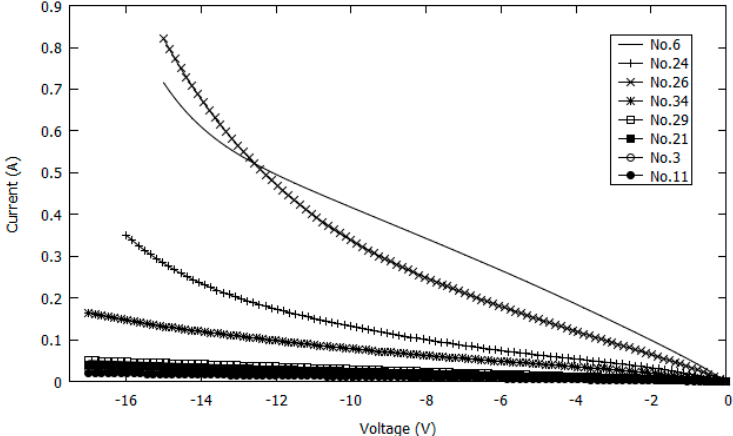
Figure 3. Reverse bias I - V characteristics of different cells belonging to the test module in dark conditions. The great dispersion in second quadrant behavior is notorious.